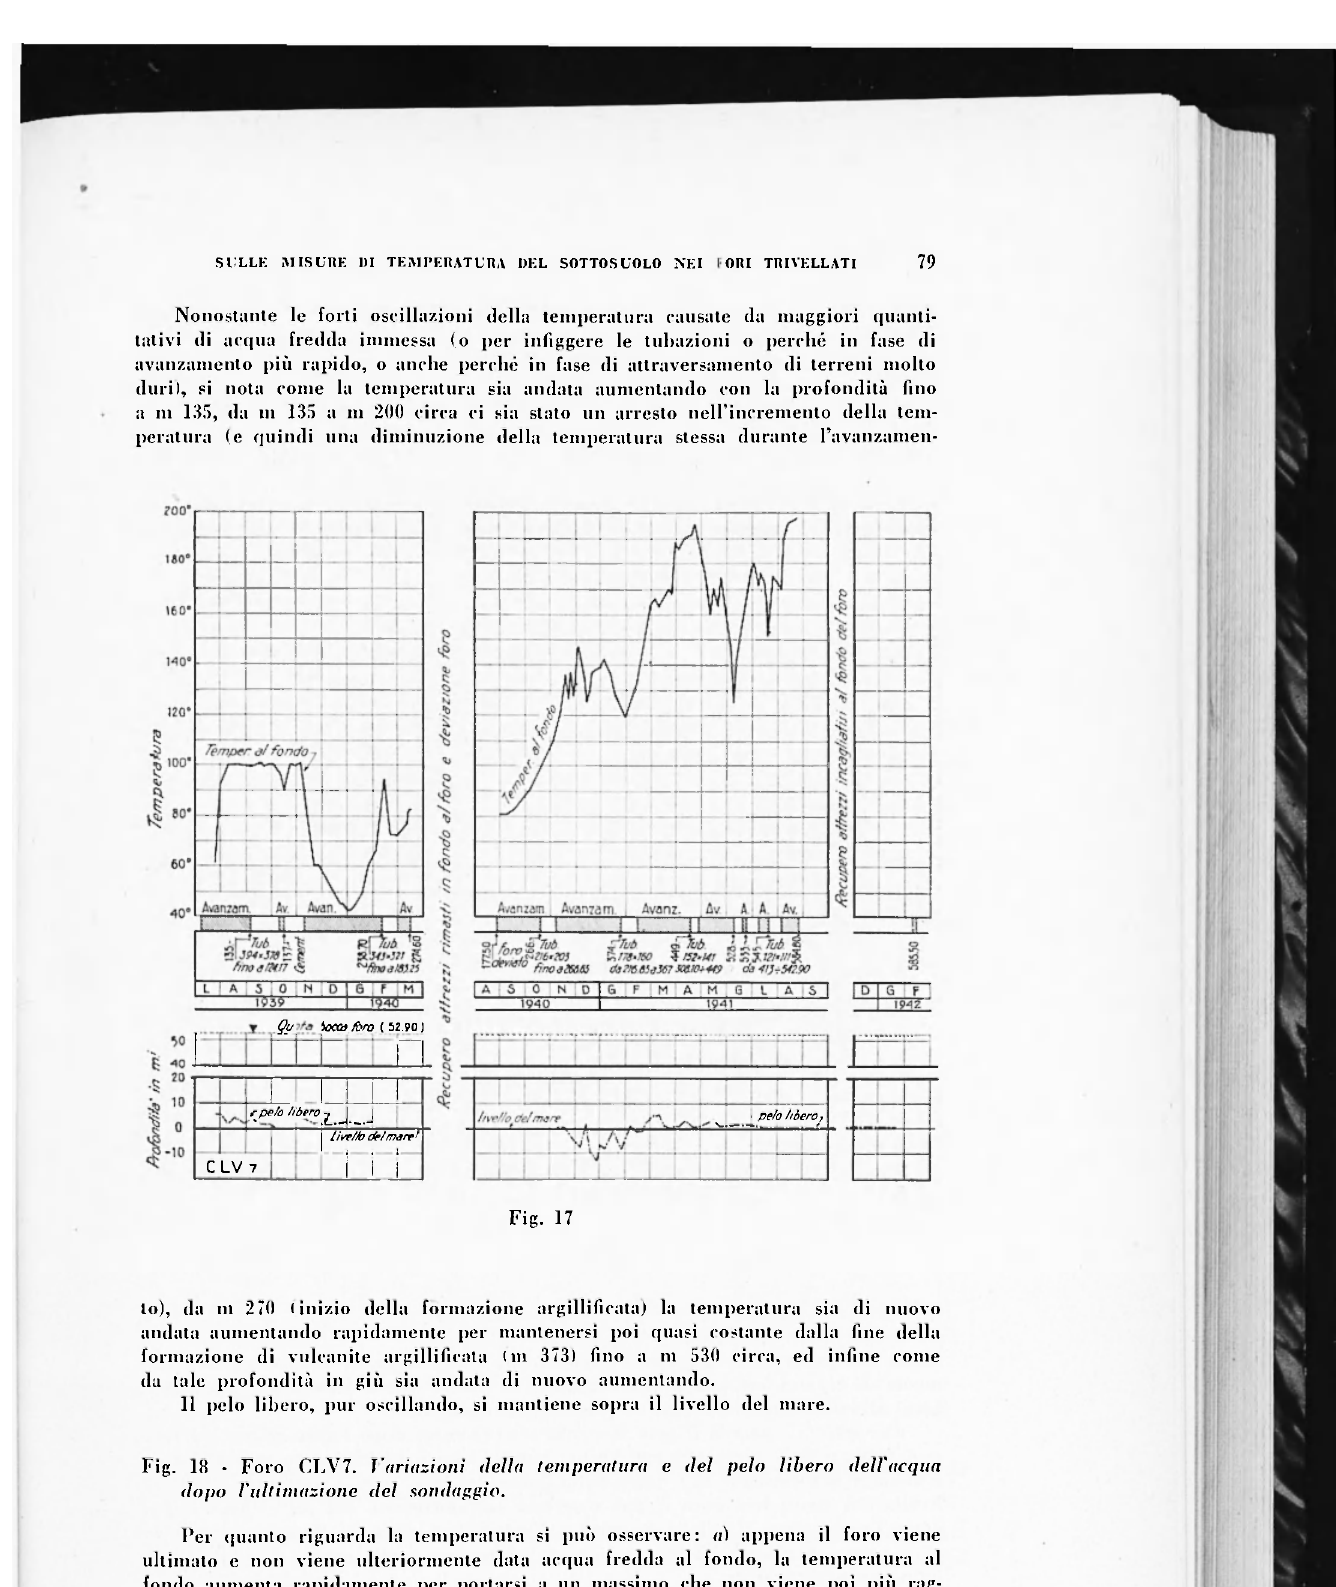
11 pelo libero, pur oscillando, si mantiene sopra il livello del mare. Fig. 18 - Foro CLV7. Variazioni della temperatura e del pelo libero dell'acqua dopo l'ultimazione del